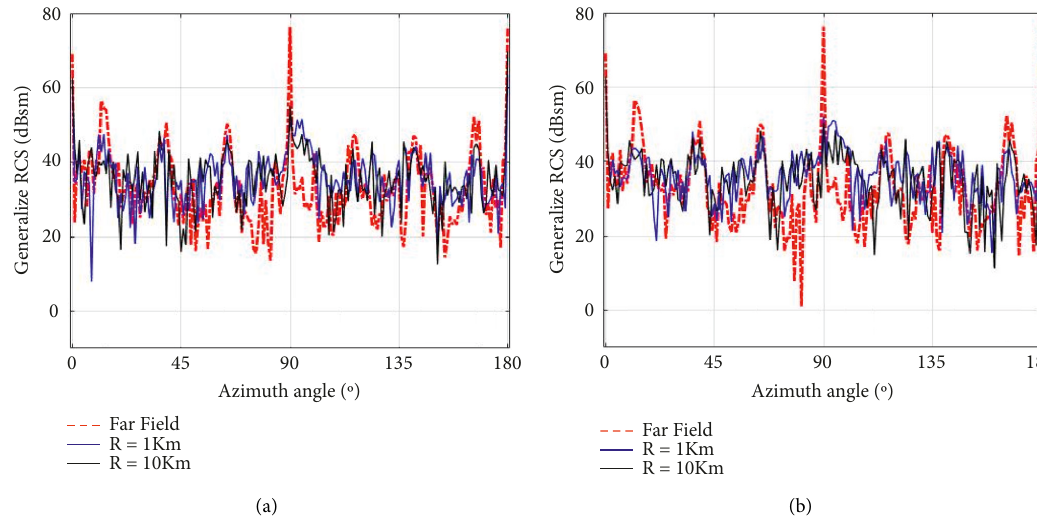
Figure 4: Scattering differences between far field and near field. (a) HH polarization. (b) VV polarization.